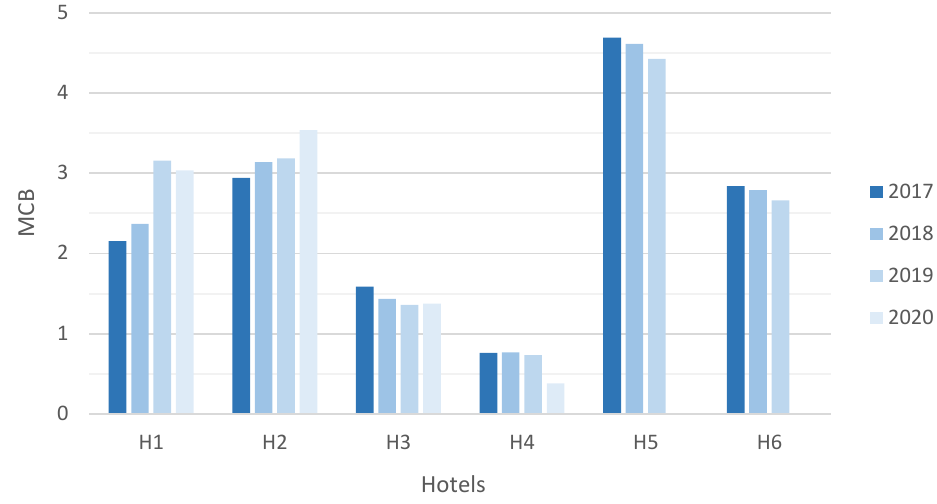
Figure 6. HWCI results for all six hotels from 2017 until 2020.